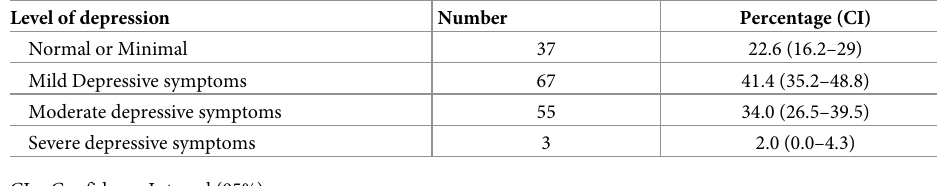
Table 3. Distribution of participants by depression-related